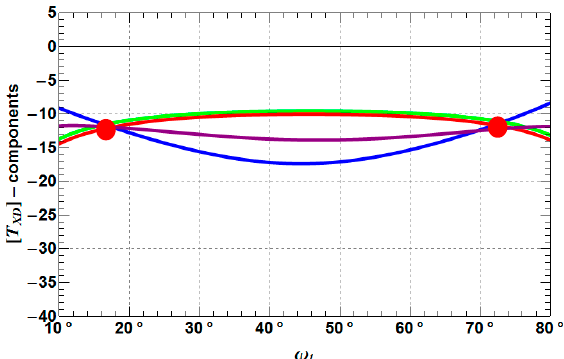
Figure 6. Sensitivity of coherency matrix elements T XD11 (blue), T XD12 (purple), T XD22 (red) and T XD33 (green) (dB) with local incidence angle ω l ( ε s = 20, ε t = 10, θ 1 = 50°, L SXD = 1, ϕ = 0°). Red points indicate the Brewster angle locations.